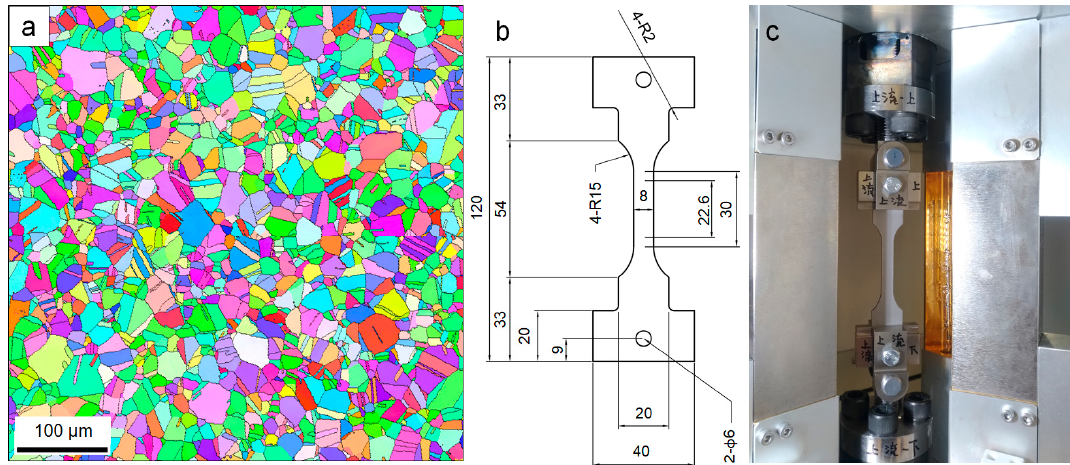
Figure 1. ( a ) Initial grain structure of the sample, ( b ) shape of the tensile coupon, and ( c ) image of the coupon fixed on the deformation-testing